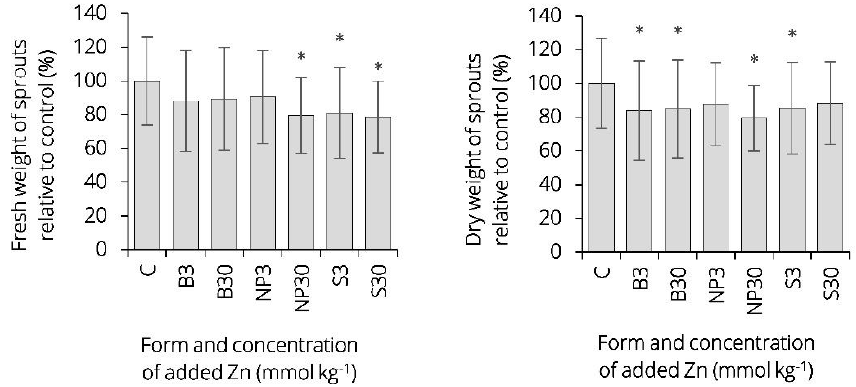
Figure 4. The average relative fresh and dry weight (an average weight of Zn-treated groups compared to the control group) of sprout biomass of barley ( Hordeum vulgare L.) plants after 10-day cultivation. The data represent mean values ± SD of three independent measurements with seven plants each. Asterisk ( * ) denotes statistically significant difference between Zn-treated groups and control group on significance level α = 0.05. Zinc was applied in three different forms (bulk, nano-sized, and dissolved) and two concentration levels (3 and 30 mmol Zn kg −1 ). For characteristics of C, B3, B30, NP3, NP30, S3, S30, see Table 3.